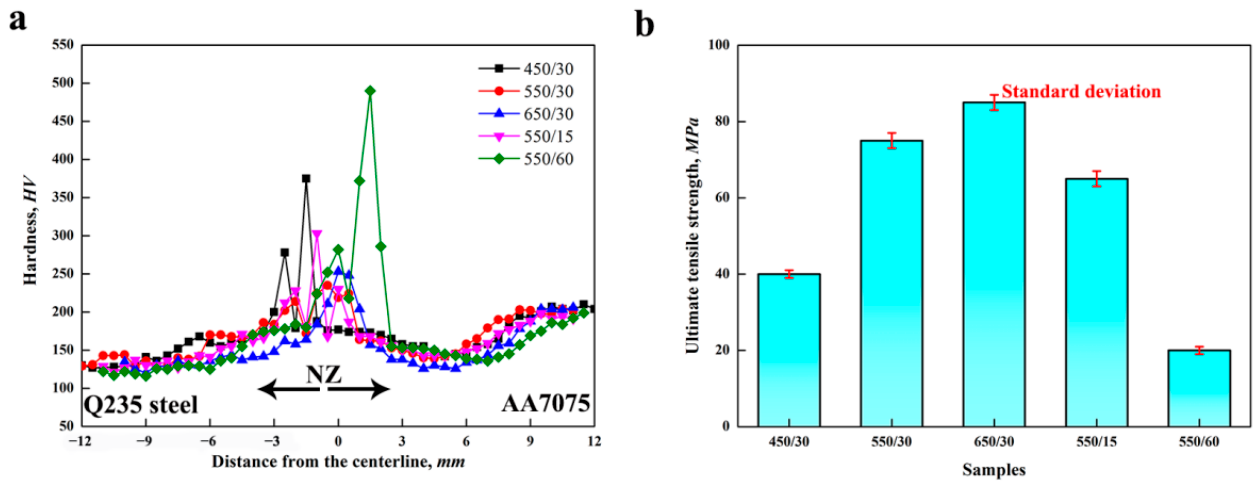
Figure 9. ( a ) The hardness profiles and ( b ) ultimate tensile strengths of all the FSW joints. The images of the fracture tensile specimens are shown in Figure 10; all the joints are failed without obvious necking. The fracture occurs inside the NZ and close to the Al/steel interface (Figure 10a–e). For the samples produced under the cold FSW condi- tion (i.e., the 450/30 and 550/60 samples), large steel strips/blocks are pulled out of Al matrix during tensile test, and then the left cavities of steel can be defected on the fracture surface (Figure 10f,j). In contrast, the fracture surfaces of other samples are relatively flat without the cavities, indicating that the specimens fail along the IMC layers (Figure 10g–i). Unfortunately, the elongation is less than 5% for all the FSW samples, the fracture mode is brittle, and no dimples can be found (Figure 11). Hence, much work remains to obtain ductile